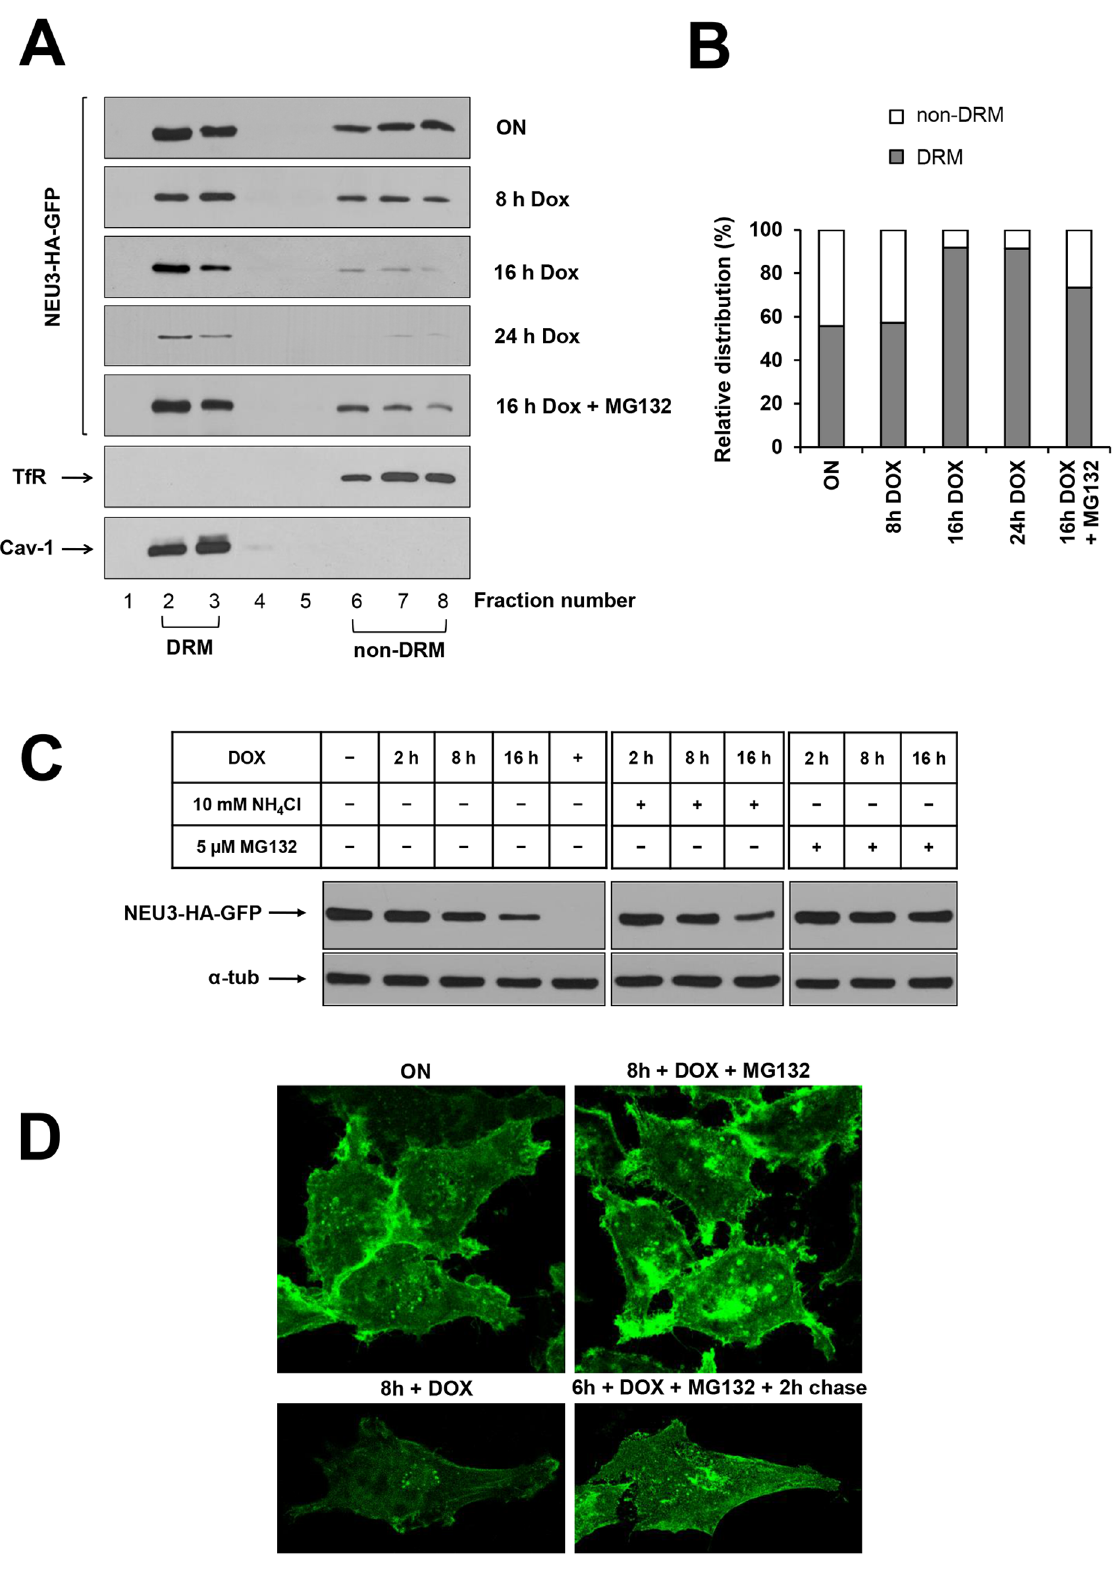
Figure 5. NEU3-HA-GFP is specifically degraded by the proteasomal machinery. (A) ON HeLa tTA2 NEU3-HA-GFP were grown in presence of dox for the indicated time periods, with or without 5 m M MG132, and extracted in the appropriate buffer containing 1% Triton X-100 for 30 min at 4 u C. DRM and non-DRM were separated by Opti-Prep density gradient centrifugation. Equal amounts of each gradient fraction were analyzed by western blot using anti-HA, anti-Transferrin Receptor (TfR) and anti-Caveolin-1 (Cav-1) primary antibodies. (B) Relative distribution of NEU3-HA-GFP